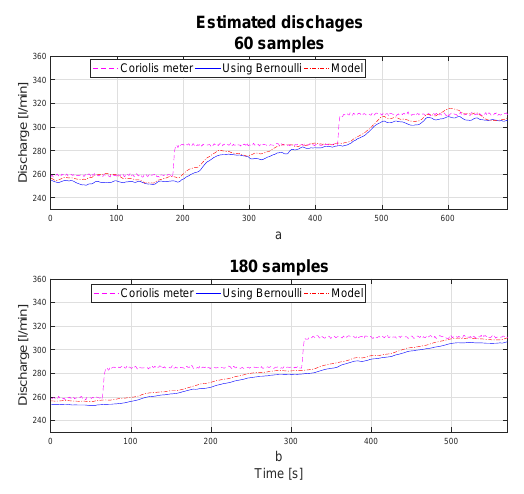
Figure 12: Flow estimation after a step change filter introduces a larger delay in the estimation of the discharge despite the filtered signals being more